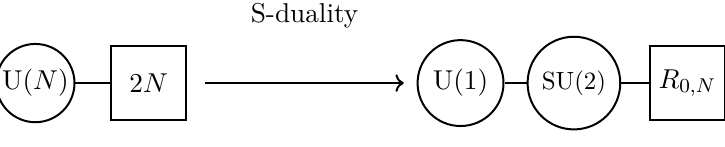
Figure 1 . S-dual theory of a single quiver